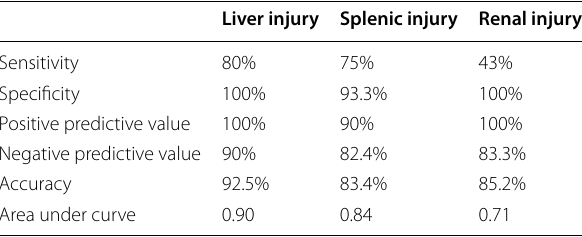
Table 6 Accuracy of U/S in diagnosing liver, splenic and renal injuries